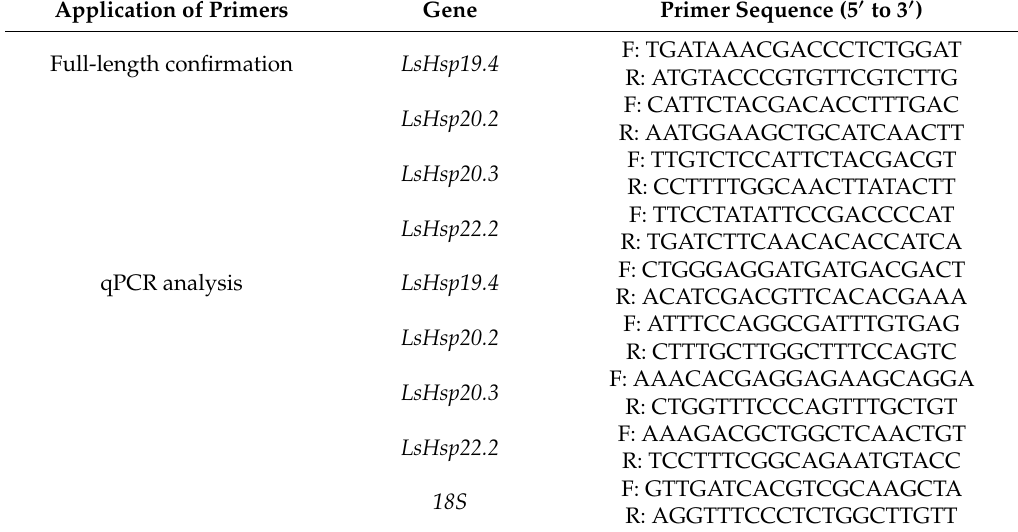
Table 1. Primers used in this